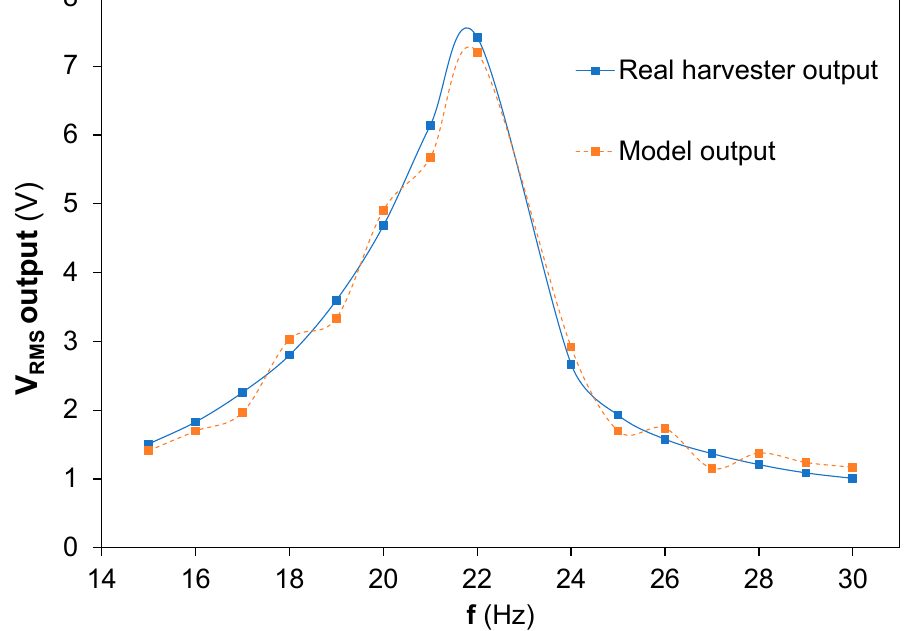
Figure 10. V rms output experimental and theoretical versus frequency.